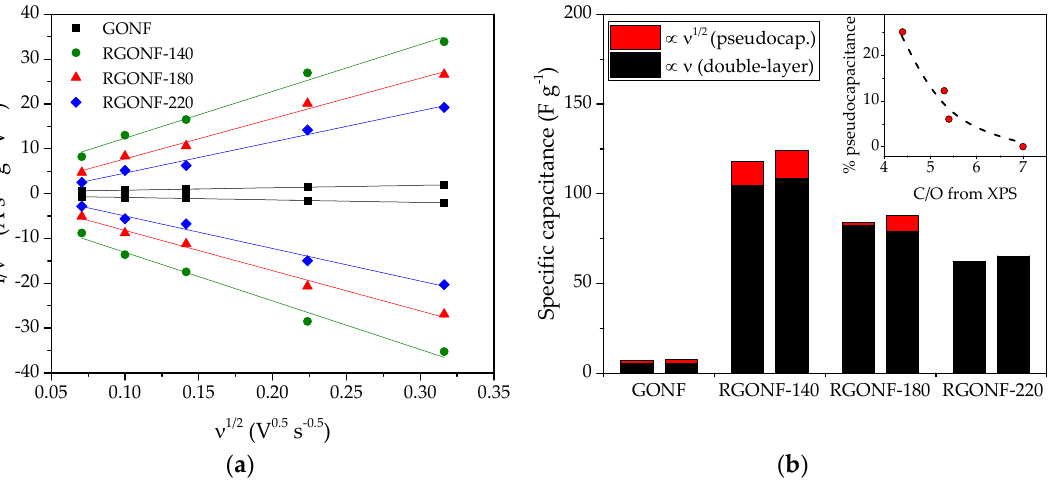
Figure 7. ( a ) Dependence of i / ν 1/2 with ν 1/2 for GONF and RGONFs at 0.5 V vs. RHE. ( b ) Specific capacitances determined from the deconvolution in Figure 7a separated in pseudocapacitance (red, ∝ ν 1/2 ) and double layer capacitance (black, ∝ ν ), for the positive- and negative-going scans being the left and right column, respectively, for each material; the inset represents the percentage of pseudocapacitance as a function of C/O ratio from XPS.